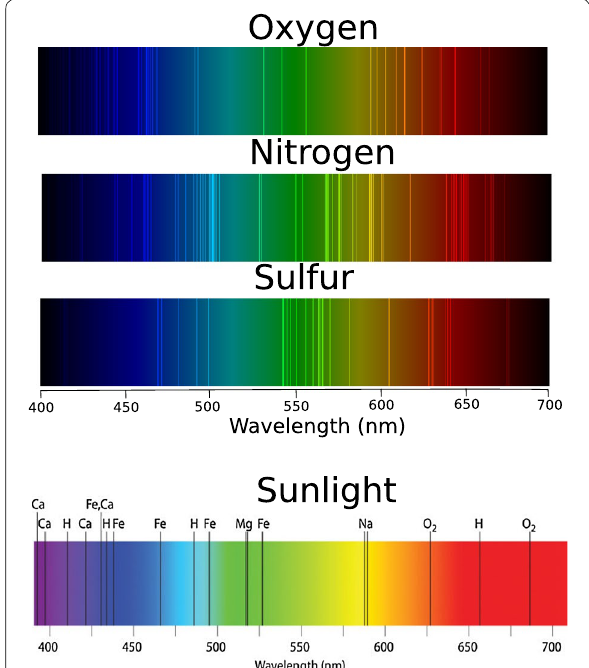
Fig. 1 From top to bottom, line spectra of oxygen, nitrogen, sulfur, and solar (reflected) light, with wavelengths in the horizontal axes. Whereas the auroral lights by oxygen and nitrogen show bright emission lines, the sunlight and its reflection (solar reflected light) show dark absorption